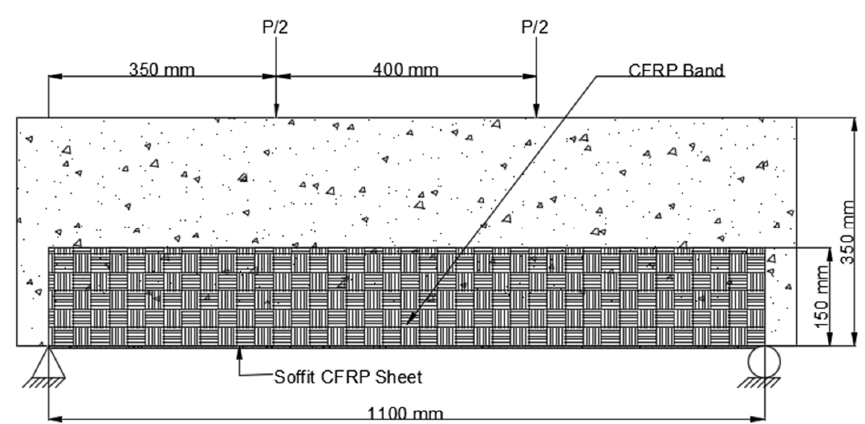
Figure 11. Placement of CFRP on beam Scheme 4 (B4).